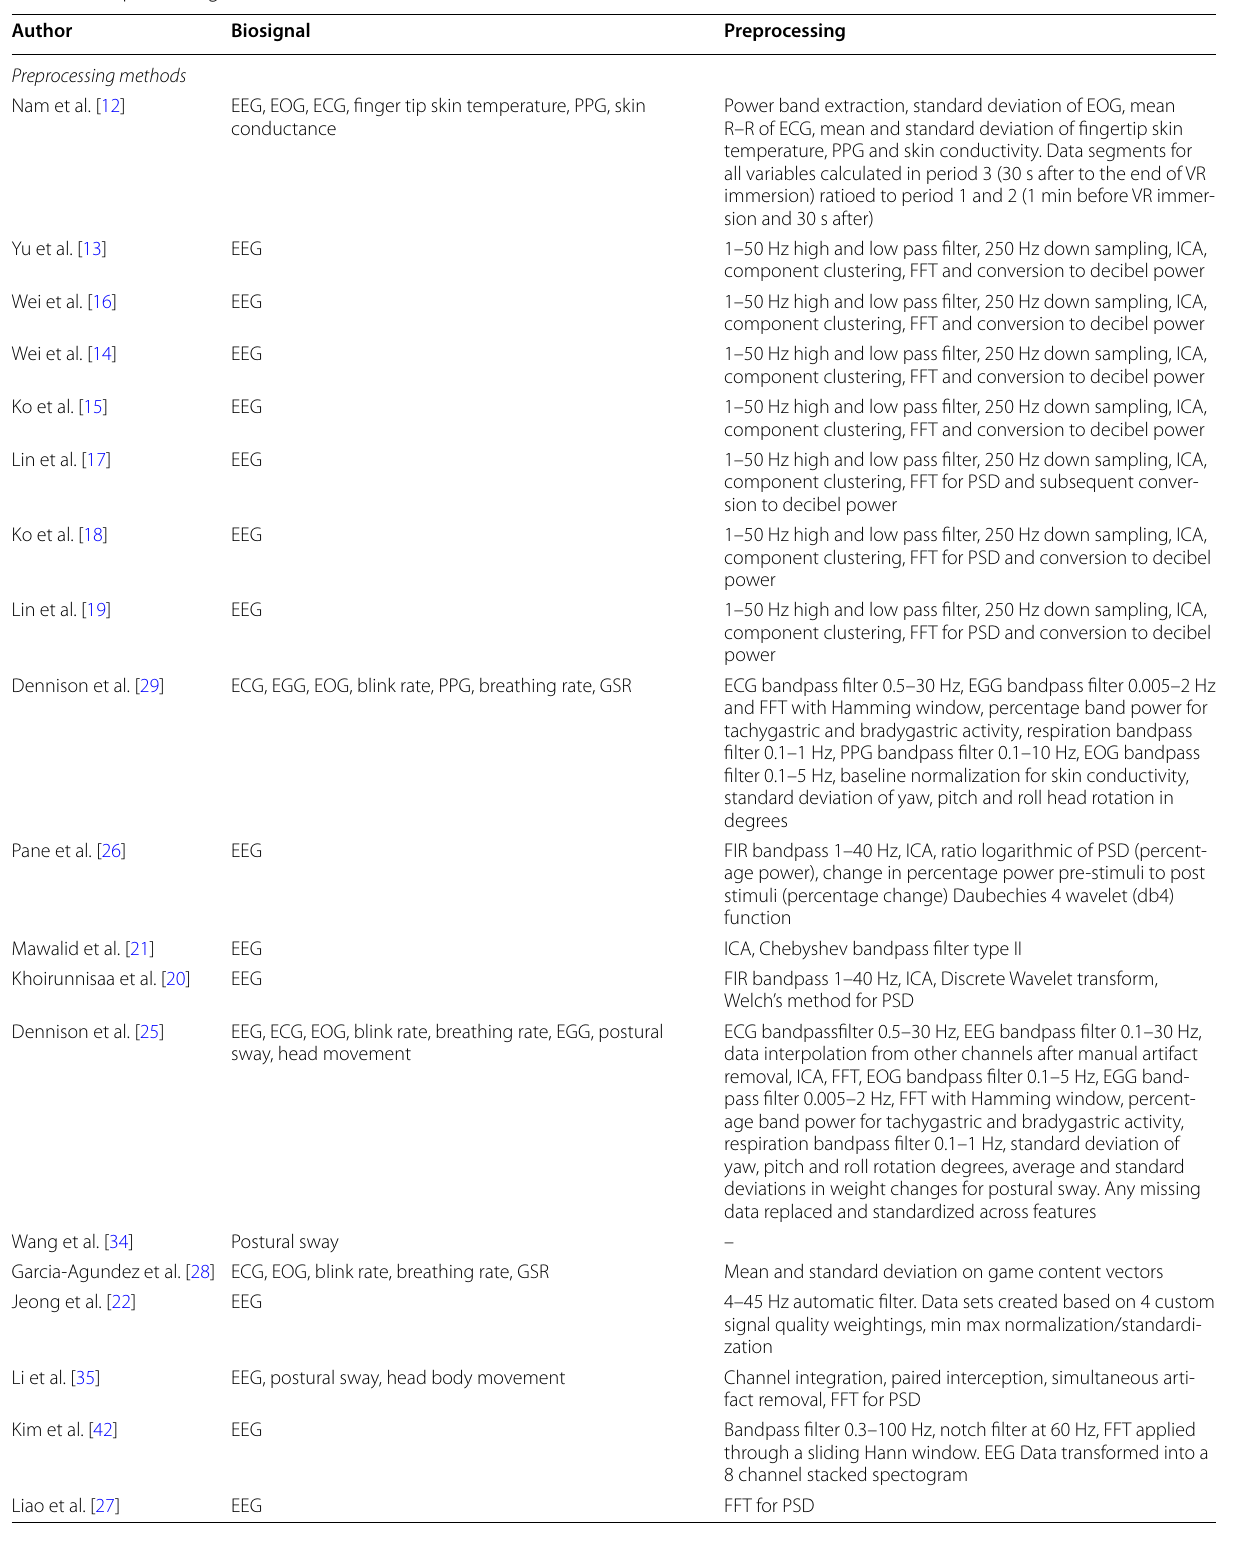
Table 7 Preprocessing